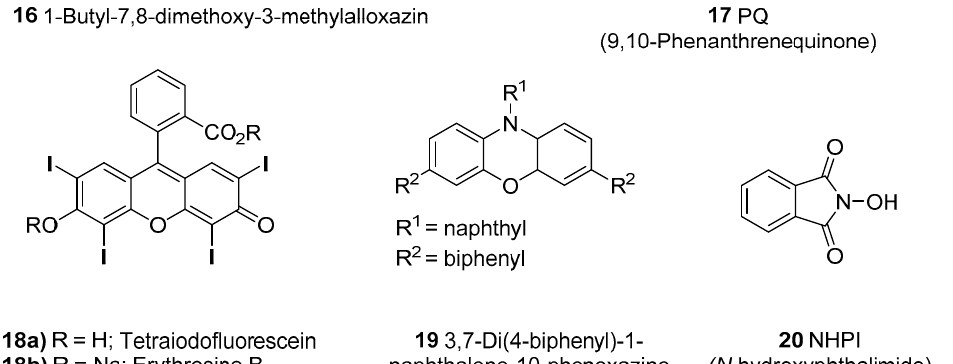
Figure 2. Examples of metal-free photoredox catalysts.